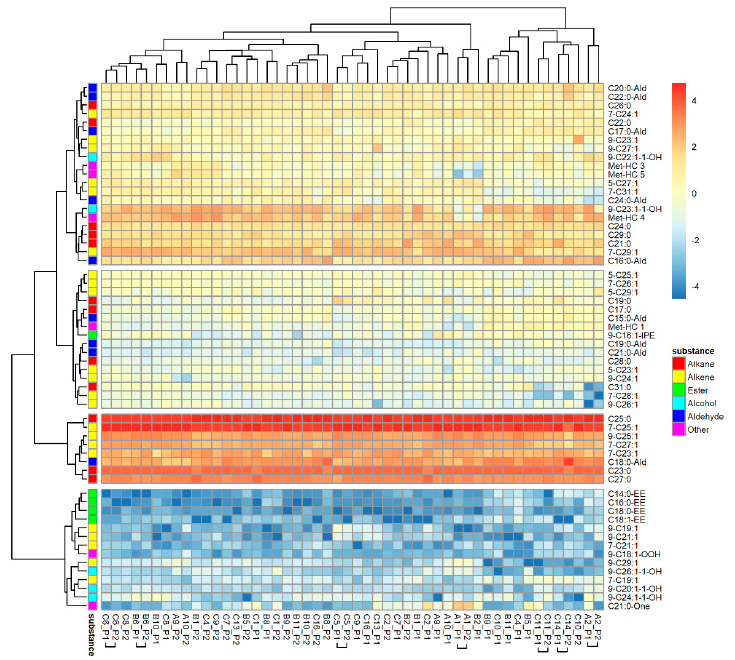
Figure 2. Composition of individual scent marks of O. cornuta nests. Compounds are arranged in rows, and odor samples are in columns of the heat map. Samples are specified by the ID of the nest